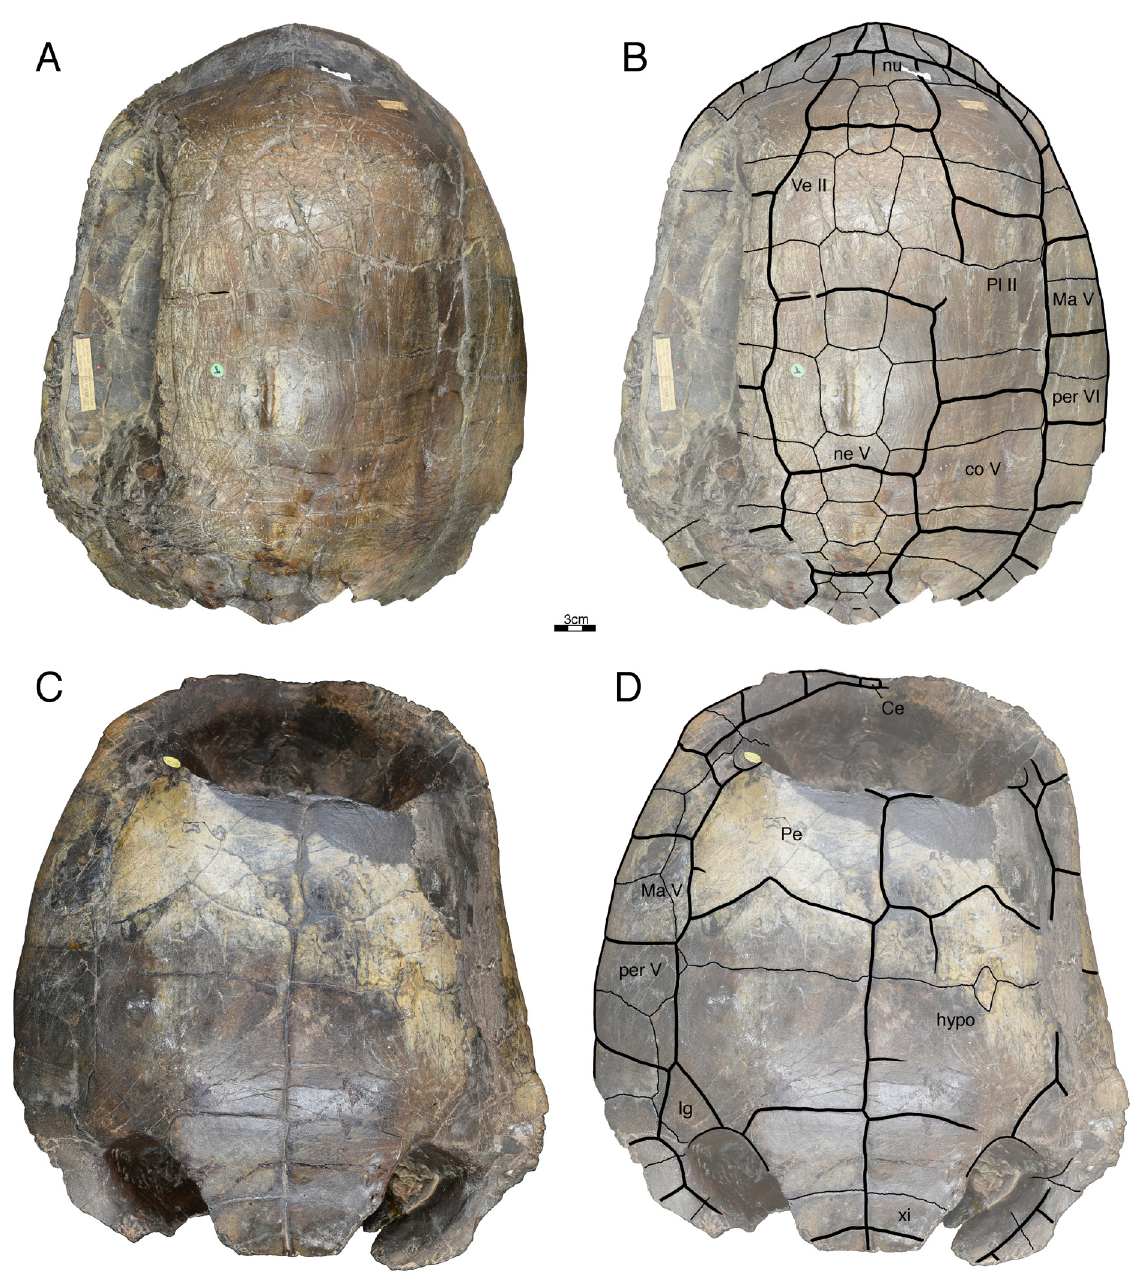
Fig. 19. BMNH 39835, holotype of Batagur falconeri Lydekker, 1885, here identified as a synonym of Hardella thurjii (Gray, 1831). A . Photograph of carapace. B . Illustration of carapace. C . Photograph of plastron. D . Illustration of plastron. Scale bar: 3